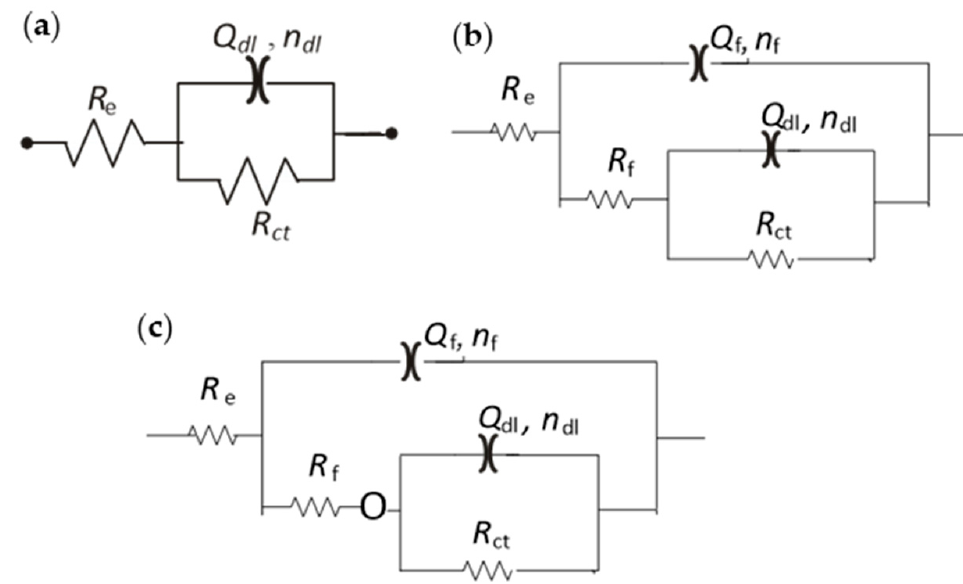
Figure 6. Equivalent electrical circuits used for fitting of EIS spectra for ( a ) bare 316L stain-less steel; ( b ) TiO 2 –ZrO 2 film annealed at 400 ◦ C; ( c ) TiO 2 –ZrO 2 film annealed at 600 ◦ C. Impedance parameters (Table 3) show that both coatings significantly increased the value of charge transfer resistance (about 20 times) and decreased the value of double-layer capacitance, compared to bare AISI 316L steel. Thus, the corrosion of stainless steel in the pores of the coating is strongly reduced. Table 3. EIS fitting parameters for bare and coated AISI 316L stainless steel (mean value ± standard deviation) in 3 wt% NaCl.